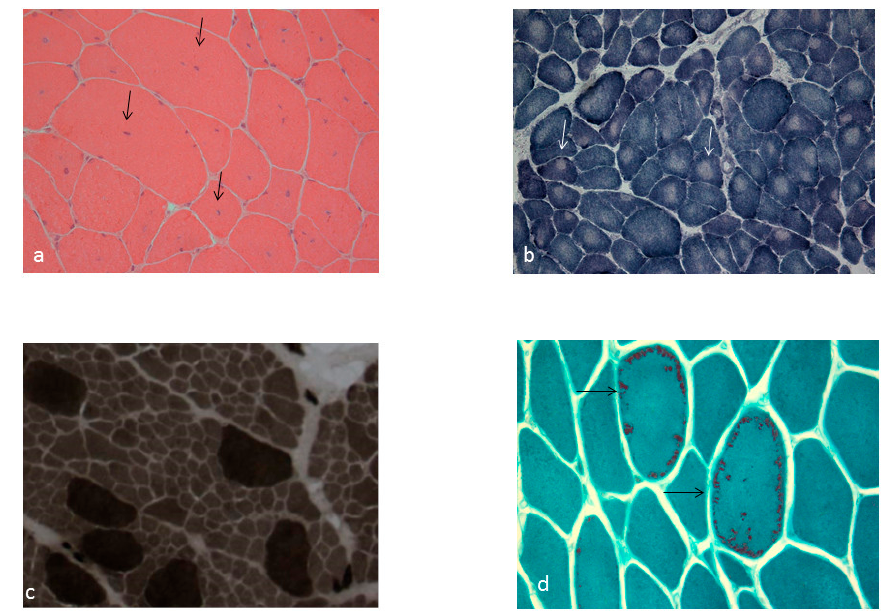
Figure 1. Muscle biopsies showing ( a ) prominent central nuclei (arrow) in a patient with centronuclear myopathy (H&E, × 20), ( b ) prominent central cores (arrow) in a patient with central core disease (NADH, × 20), ( c ) hypotrophy of type 1 muscle fibers (light) relative to type 2 (dark) in a patient with congenital muscle fiber disproportion (ATPase pH 9.4, × 20), ( d ) muscle fibers with nemaline rods (arrow) in a patient with nemaline myopathy (Gomori trichrome, × 40).